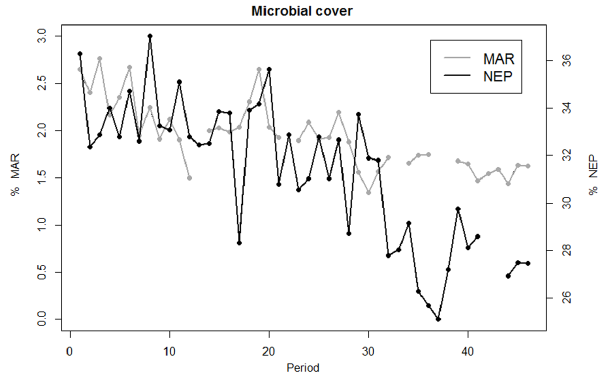
Figure 4. Percent microbial cover every 12h for the imagery period analysed. The x axis contains periods; one period is equal to